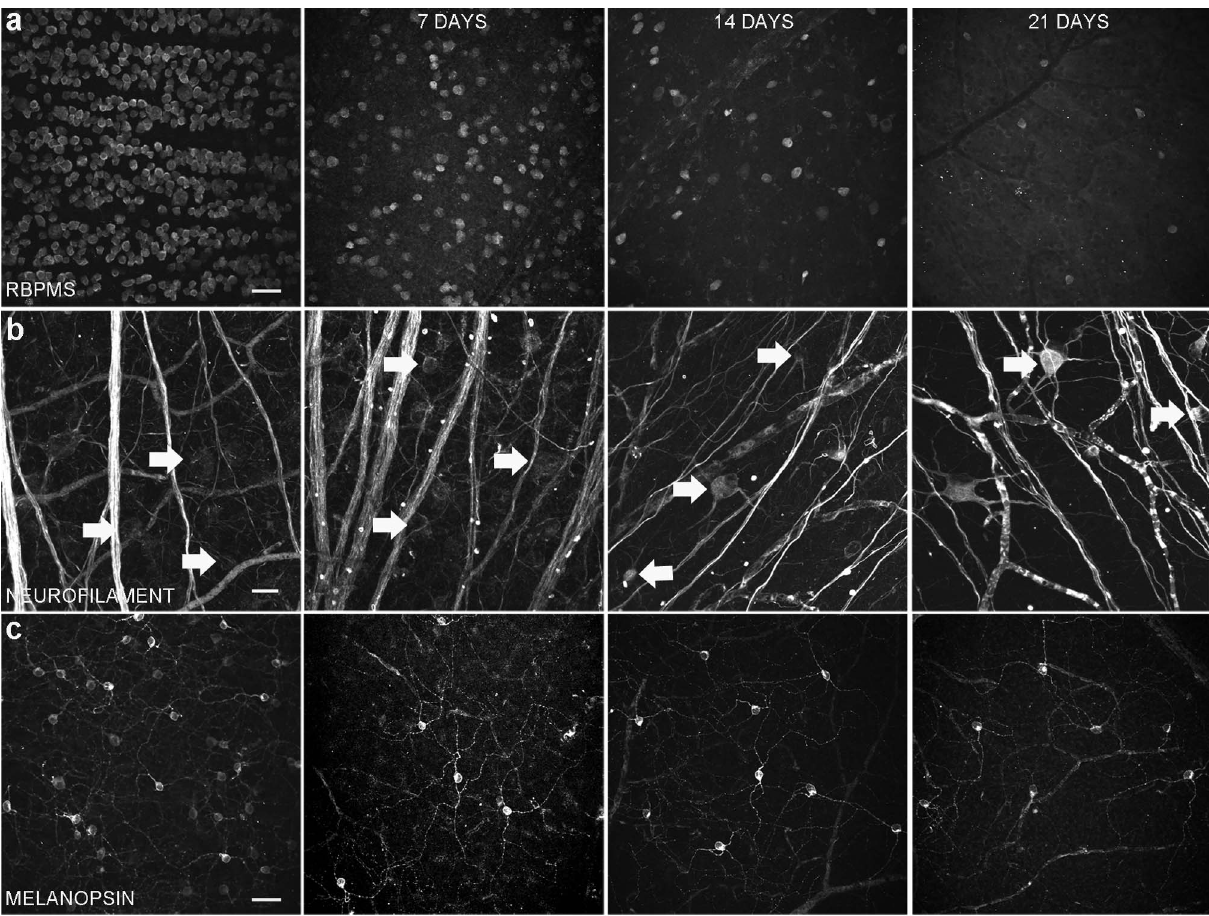
Figure 1. Whole-mounted rat retinas showing the effect of axotomy on RGC number and morphology. Left column is a control retina from the non-operated eye (a) RBPMS immunostaining (a specific marker for ganglion cells) in the ganglion cell layer at 7, 14 and 21 days after optic nerve transection. (b) Neurofilament-M immunostaining (arrows) at 7, 14 and 21 days after optic nerve transection. (c) M1 ganglion cells at 7, 14 and 21 days after optic nerve transection. (a, c) Scale bar=50 m m; (b) Scale bar=20 m m. doi:10.1371/journal.pone.0093274.g001 ganglion cells from non-injured retinas (n= 26 M1 ganglion cells n =19 cells from 2 retinas at 14 days after ONT, p = 0.498; n= 37 from 3 retinas). cells from 5 retinas at 21 days after ONT, p= 0.834; n = 28 cells Dendritic field size. M1 ganglion cell dendritic field size from 3 retinas at 60 days after ONT, p= 0.881) compared to M1 significantly increased 7 days after ONT (n =16 cells; major